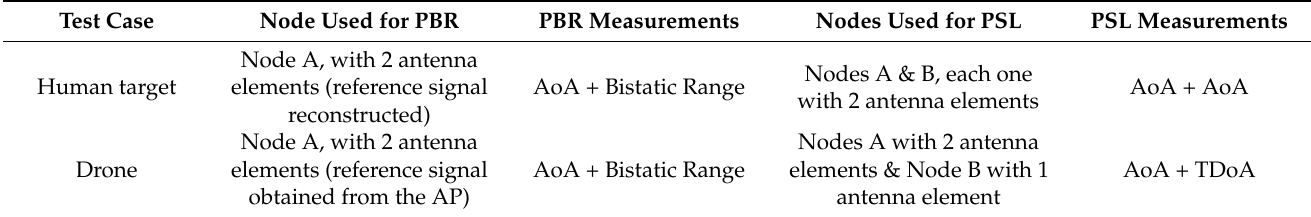
Table 5. Characteristics of the proposed test